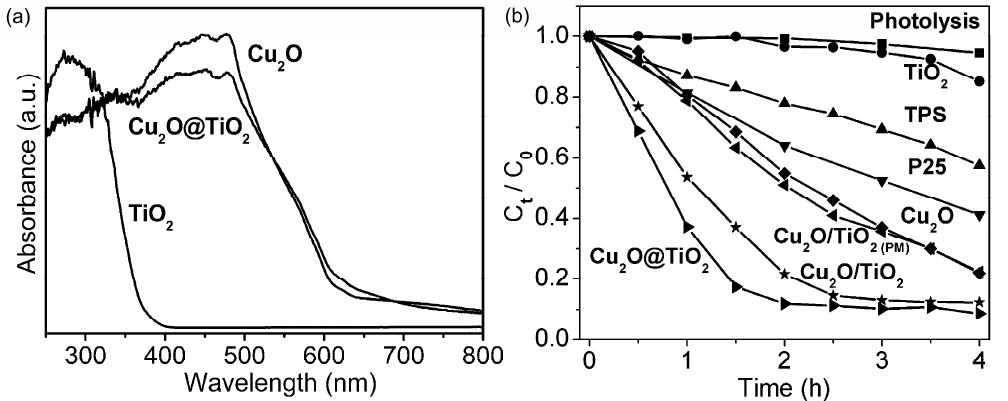
Figure 14. ( a ) UV–Vis diffuse reflection spectra of pure Cu 2 O and Cu 2 O@TiO 2 sample; ( b ) comparison of photocatalytic degradation of 4 ‐ nitrophenol under solar light in the absence of the photocatalyst and over different photocatalytic systems. Reprinted with permission from [101]. Copyright Elsevier, 2011.